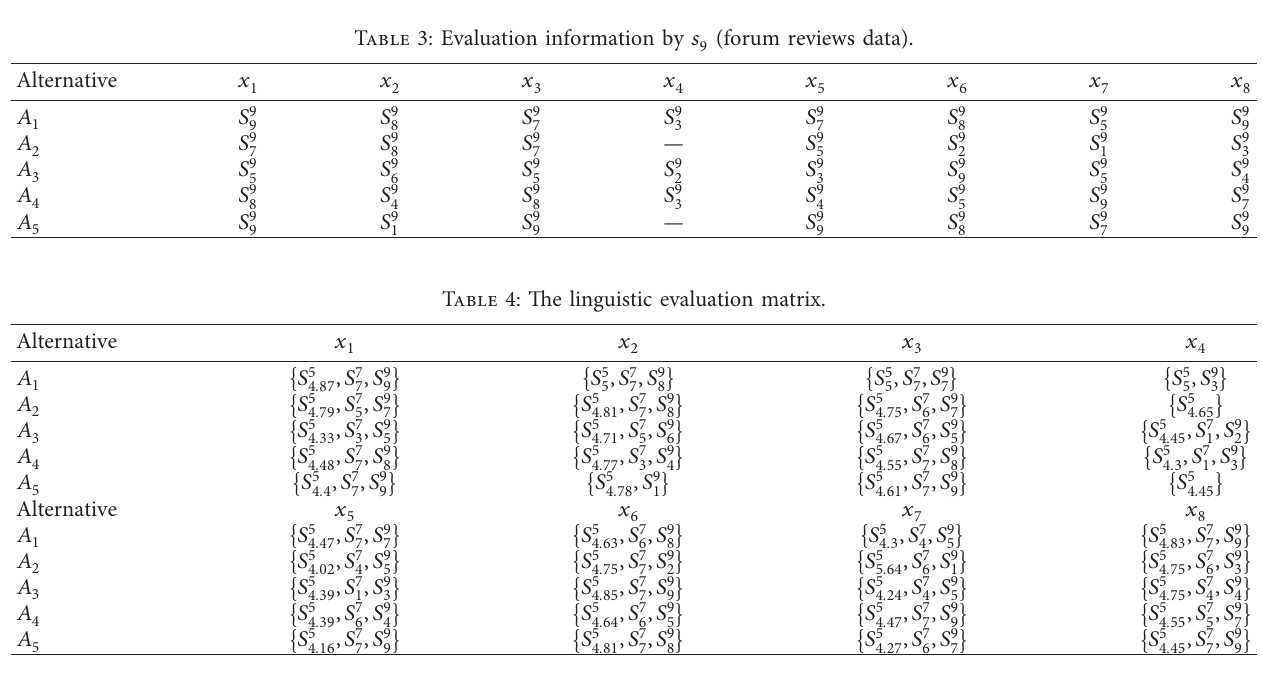
Table 3: Evaluation information by s